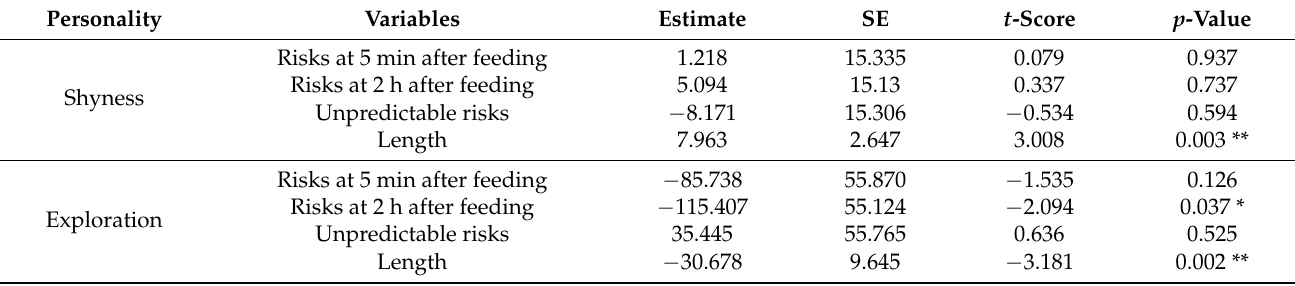
Table 2. The effects of risk predictability on the personality traits of female mosquitofish with body length as a